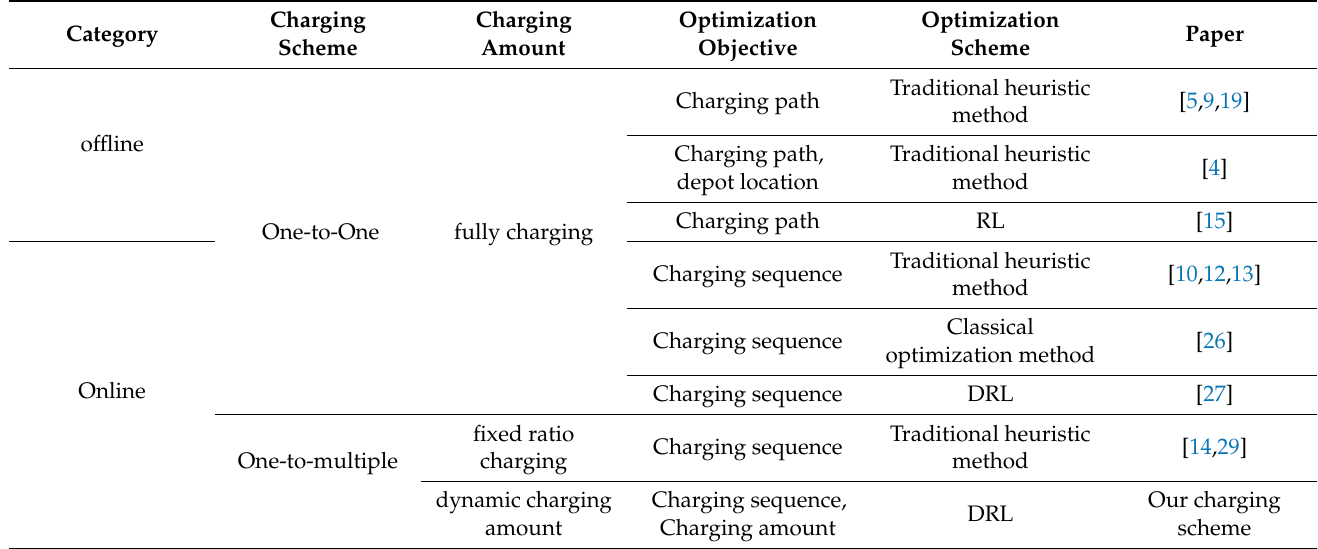
Table 1. Comparison of our charging scheme with existing